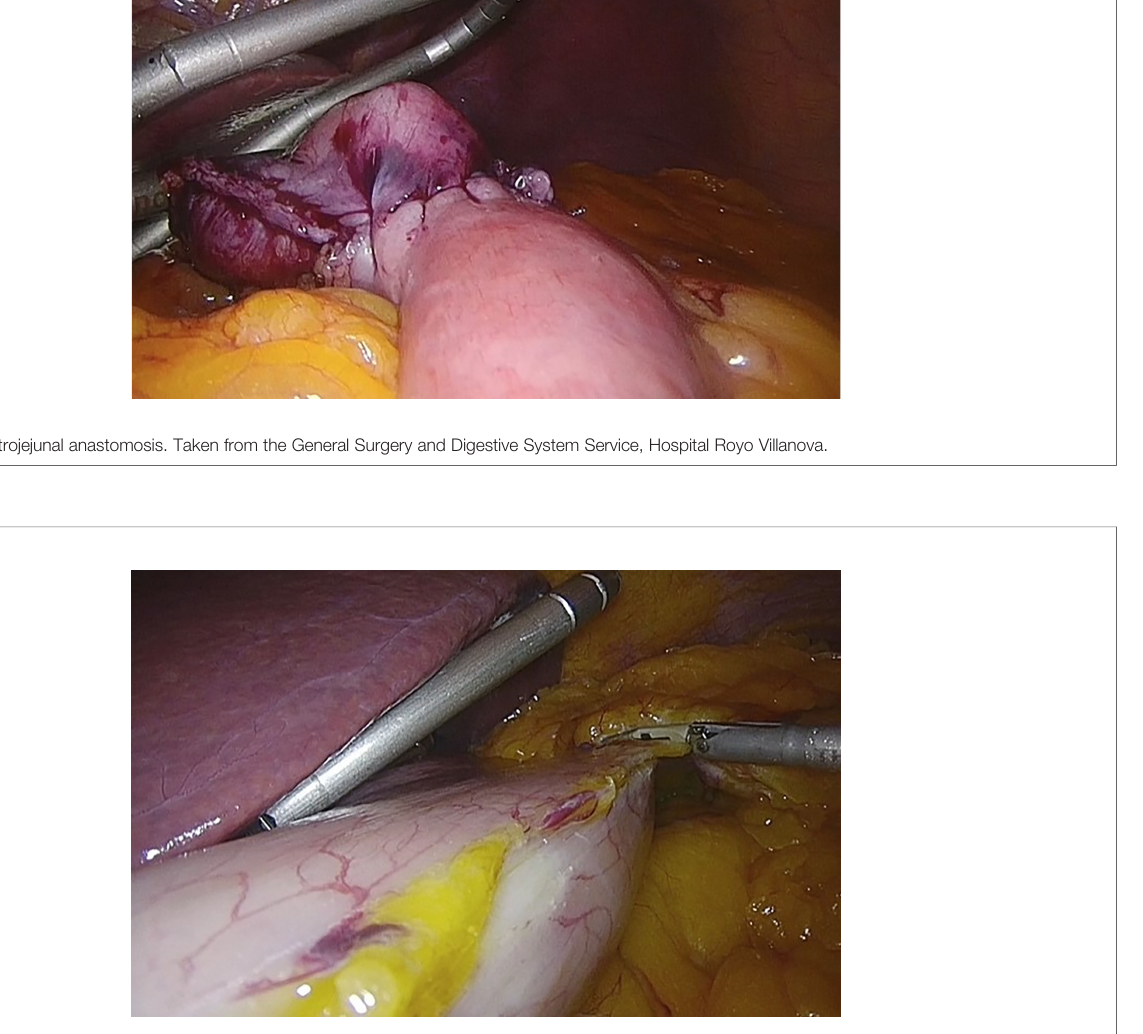
FIGURE 4 | Release of the horizontal major bend and the bottom of the vertical major bend using the Thunderbeat. Taken from the General Surgery and Digestive System Service, Hospital Royo Villanova.